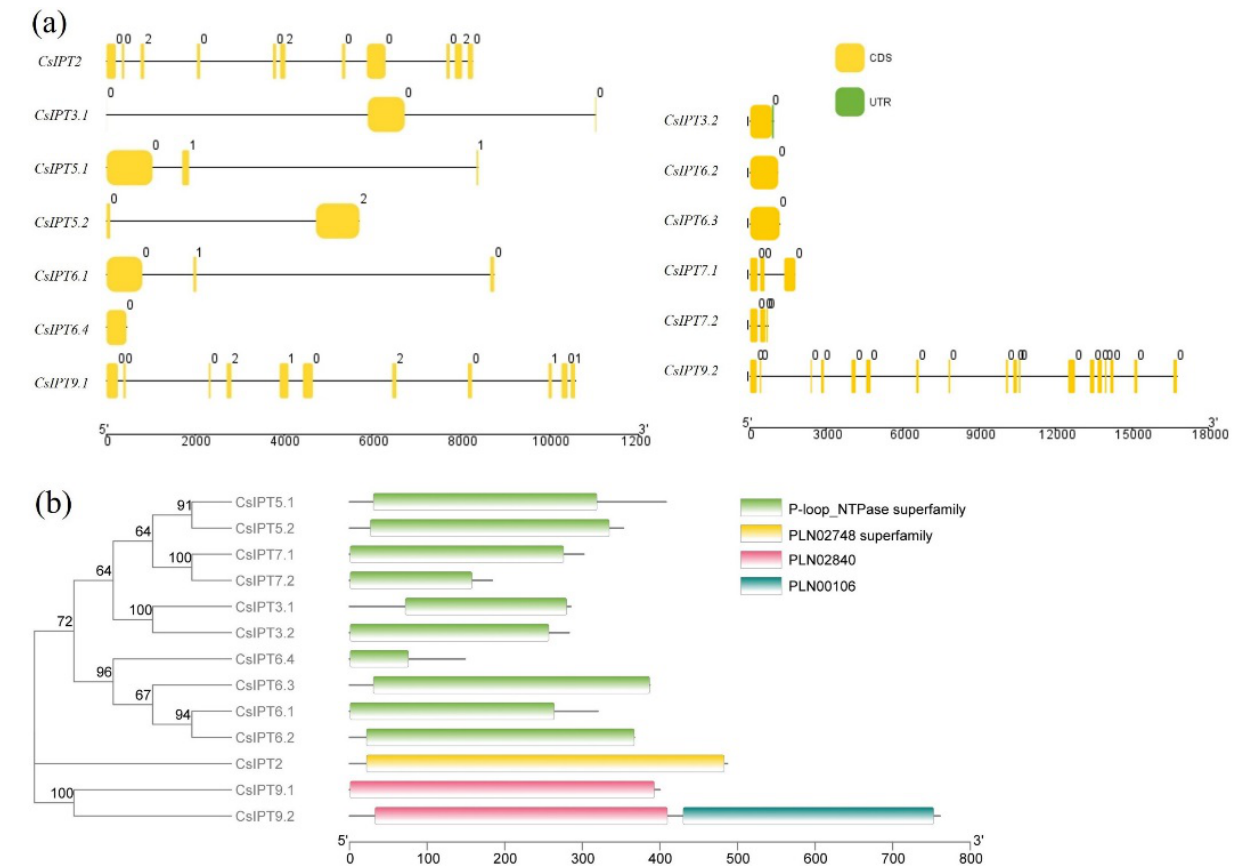
Figure 2. Gene structure and conserved domain analysis of CsIPTs. The exons and introns were represented by brown boxes and black lines ( a ). Conserved domain analysis of CsIPTs at the evolutionary level. Phylogenetic tree and conserved domains were combined into one map using the TBtools program. The relative positions of each domain within each protein were shown in color ( b ).